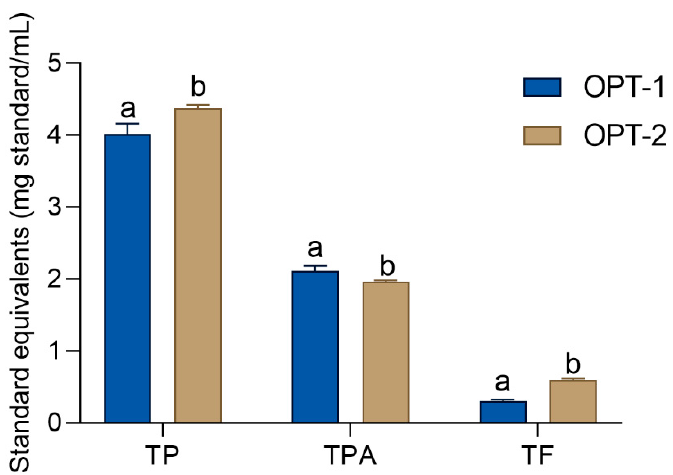
Figure 1. Total phenolic (TP), total flavonoid (TF), and total phenolic acid (TPA) content of the OPT-1 and OPT-2 extracts (prepared as described in Section 2.6). The standards equivalents for the determination of TP, TPA, and TF were gallic acid, caffeic acid, and quercetin, respectively. Different lowercase letters indicate statistically significant difference between the phenols of the same type (grouped together) (Student’s t -test, p < 0.05). The TPA in OPT 1 as well as the TP and TF in OPT 2 have been previously published in [10].